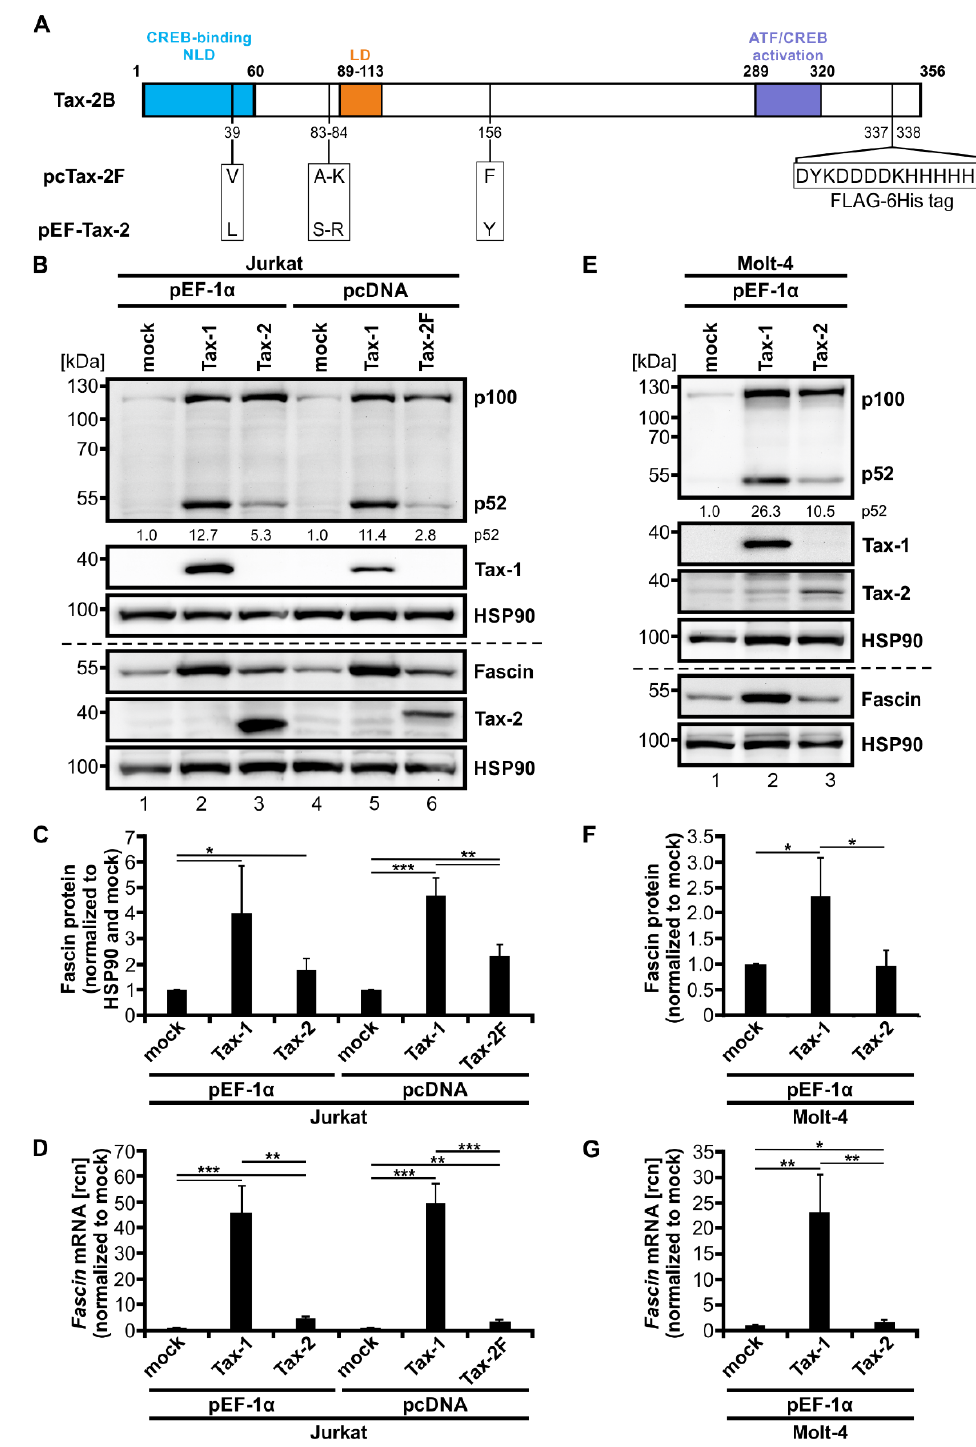
Figure 1. Tax-2 induces both Fascin expression and alternative NF- κ B signaling but is less potent than Tax-1. ( A ) Scheme of Tax-2B wildtype (wt) and sequence analysis of the two Tax-2B expression constructs pcTax-2F (with internal FLAG-6His tag) and pEF-Tax-2 (untagged). Numbers